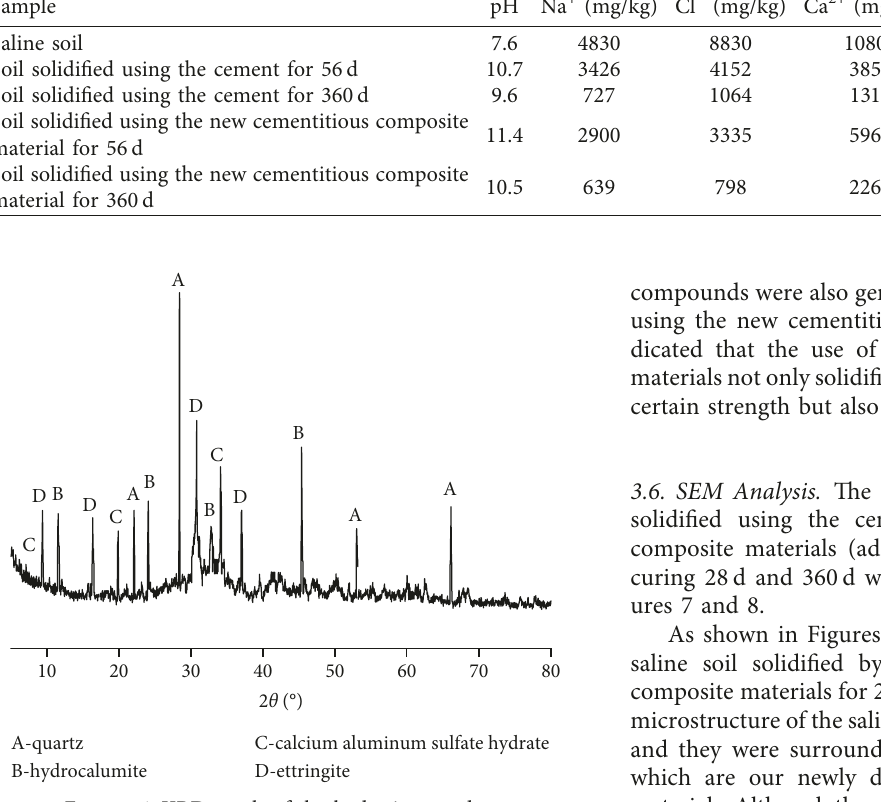
Figure 6: XRD result of the hydration